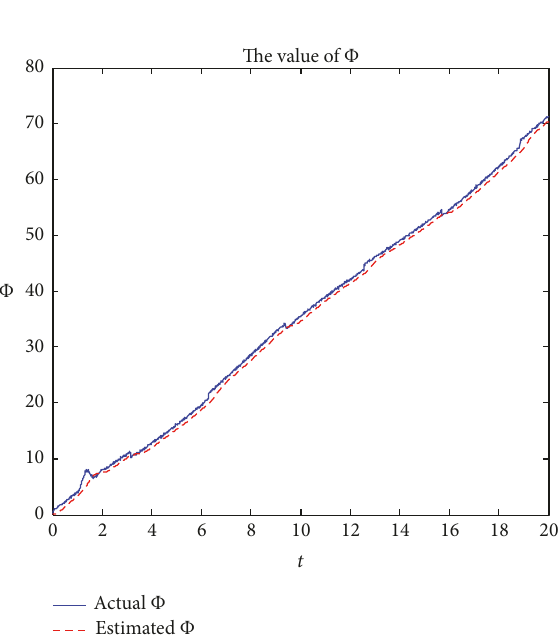
Figure5:Combination Φ(𝑥 1 , 𝑥 2 ,𝑡) estimateandtruevaluefor 𝑓 2 (𝑡)